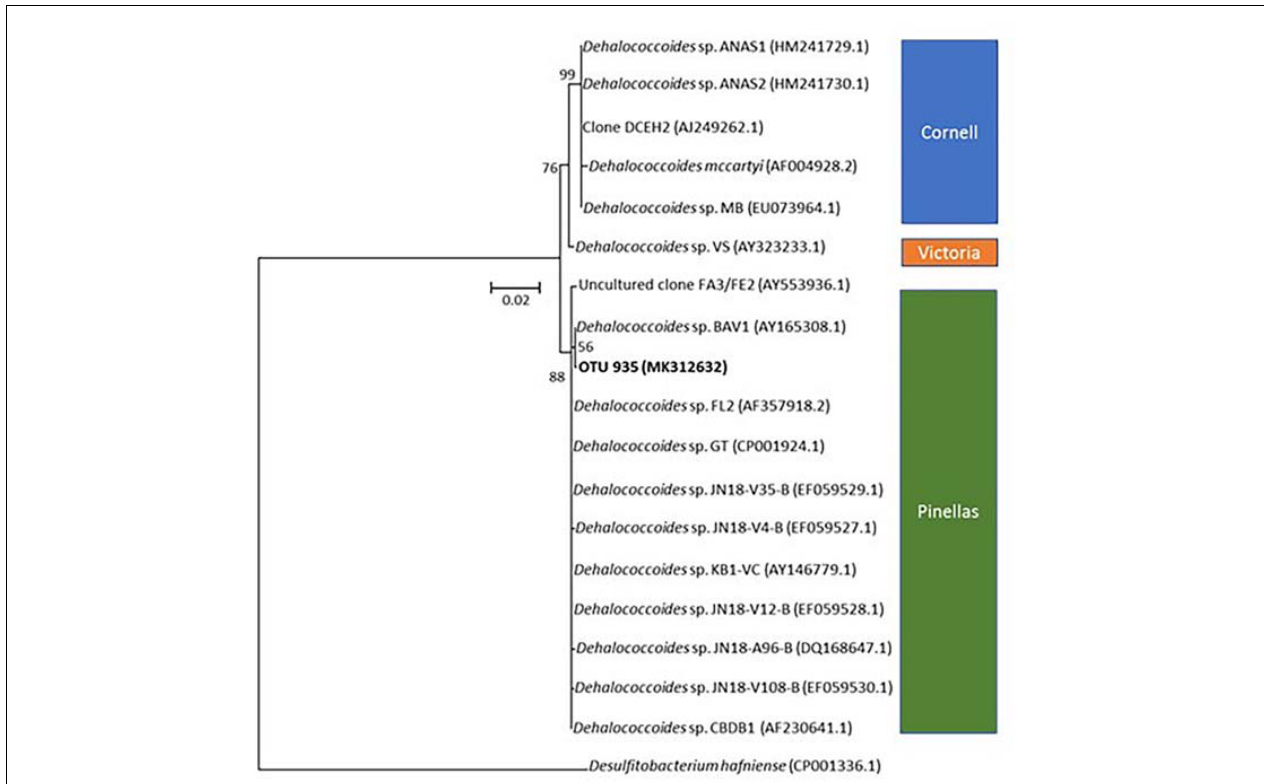
FIGURE 7 | Phylogenetic affiliation of OTU935 within genus Dehalococcoides . The tree was obtained by the Neighbor-Joining and Jukes and Cantor methods from a 923 nucleotides alignment of 16S rRNA gene sequences. OTU935 of the microcosm is displayed in bold. Dehalococcoides subgroup affiliation is also shown. Bootstrap values are expressed as the percentage of 1000